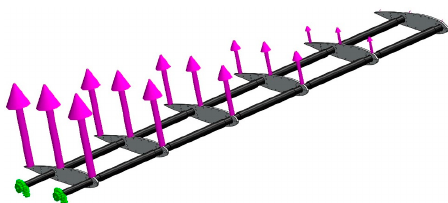
Figure 7. Static analysis on the rib-spar assembly (loads are applied at rib locations).